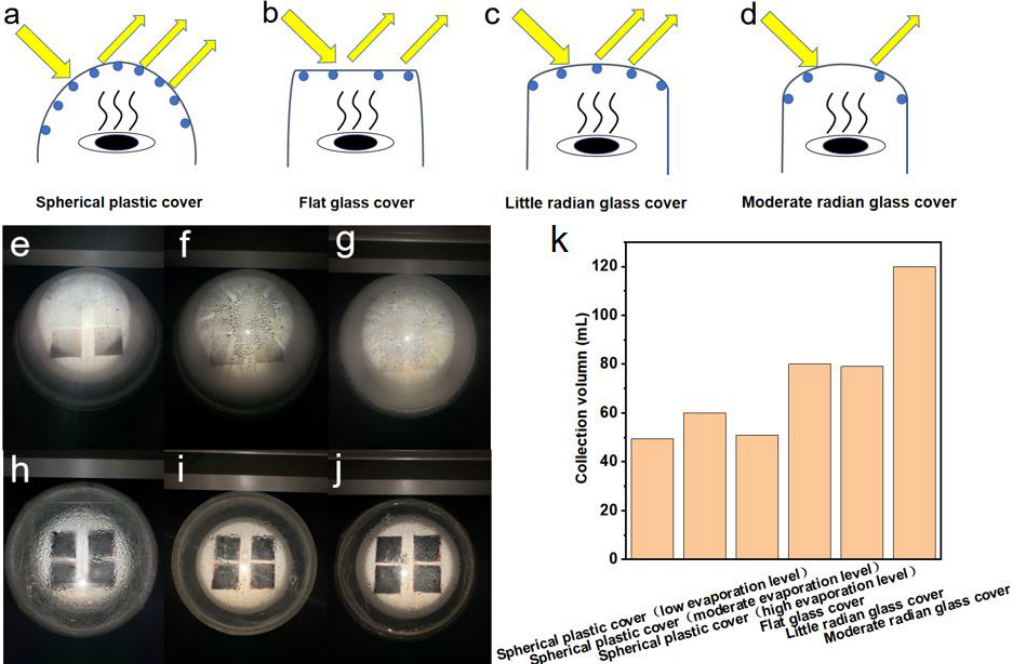
Figure 7. Scheme and solar vapor collection performance of different top covers. ( a ) Spherical plastic cover with serious optical loss. ( b ) Flat glass cover with large droplets. ( c ) Small radian glass covered with large droplets. ( d ) Moderate radian glass cover with mist. Photos of corresponding top covers: spherical plastic cover with ( e ) low, ( f ) moderate, ( g ) high evaporation levels; ( h ) flat glass cover, ( i ) small radian glass cover, and ( j ) moderate radian glass cover with moderate evaporation level. ( k ) Collection performance of different top covers.